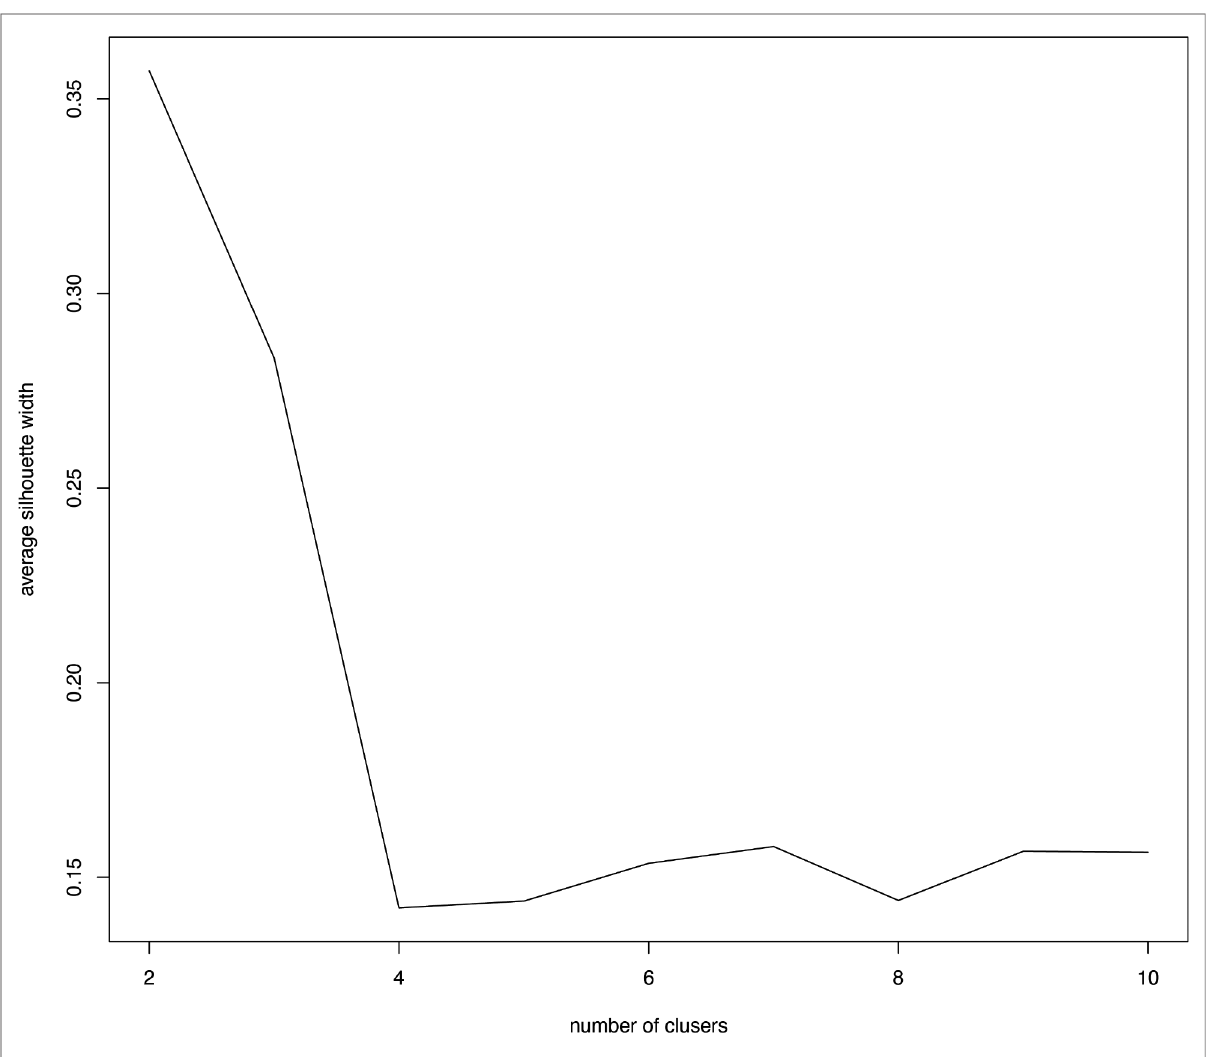
FIGURE 1 Optimal clustering number of the K-means clustering algorithm was determined by Silhouette coef fi cient (SC). The peak of the curve is the best value for the Silhouette coef fi cient ( Y -axis); the best number of clusters was equal to 2 ( X –